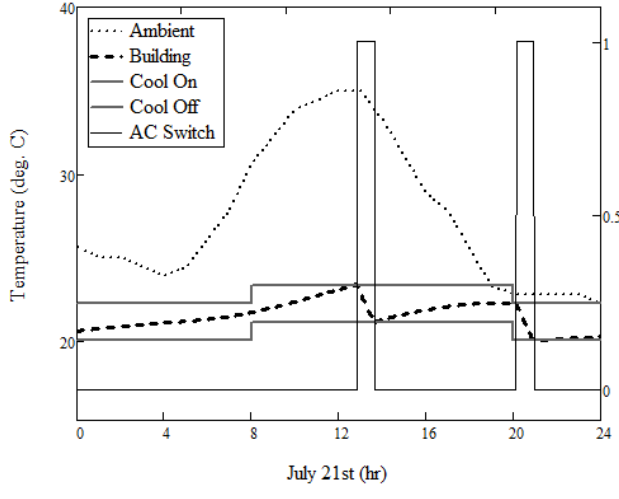
Figure 2. Air Conditioning Example from July